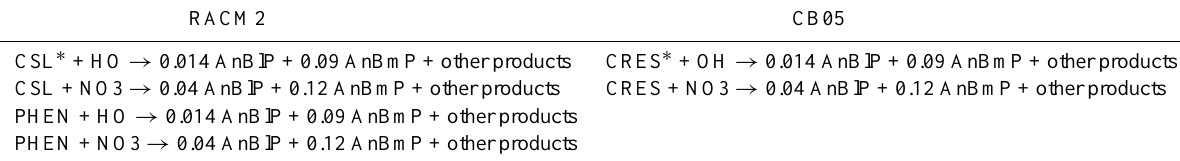
Table 3c. Cresol and phenol oxidation chemistry for SVOC formation. RACM2